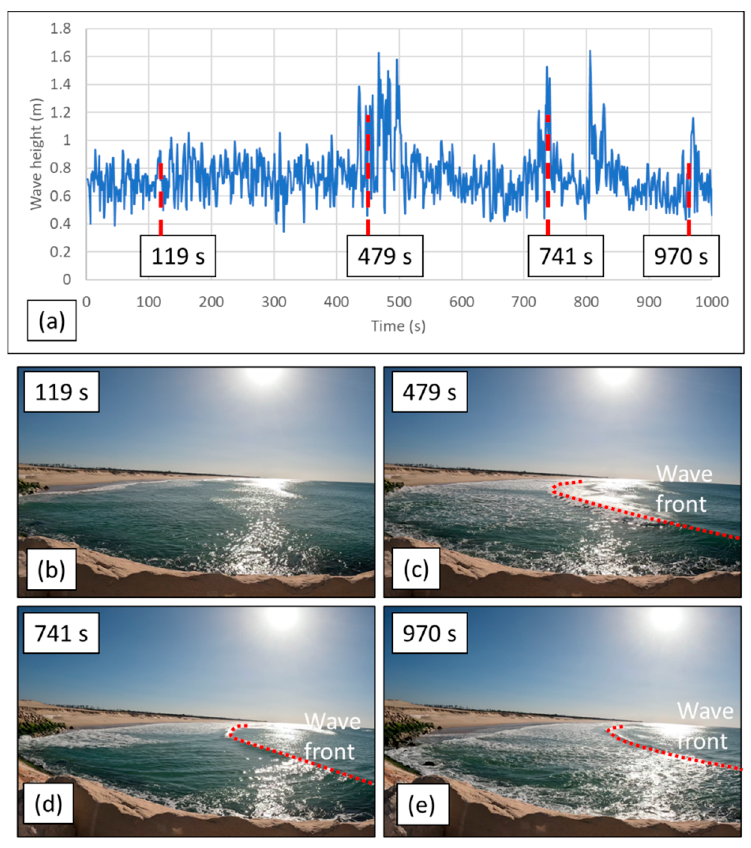
Figure 11. Time series of wave height impacting on Cova Gala (Portugal); ( a ) time series plot of wave height obtained by Optical Flow following the relationship (1); ( b ) frames of action camera at 119 s from starting video; ( c ) frames of action camera at 479 s from starting video; ( d ) frames of action camera at 741 s from starting video; ( e ) frames of action camera at 970 s from starting video.